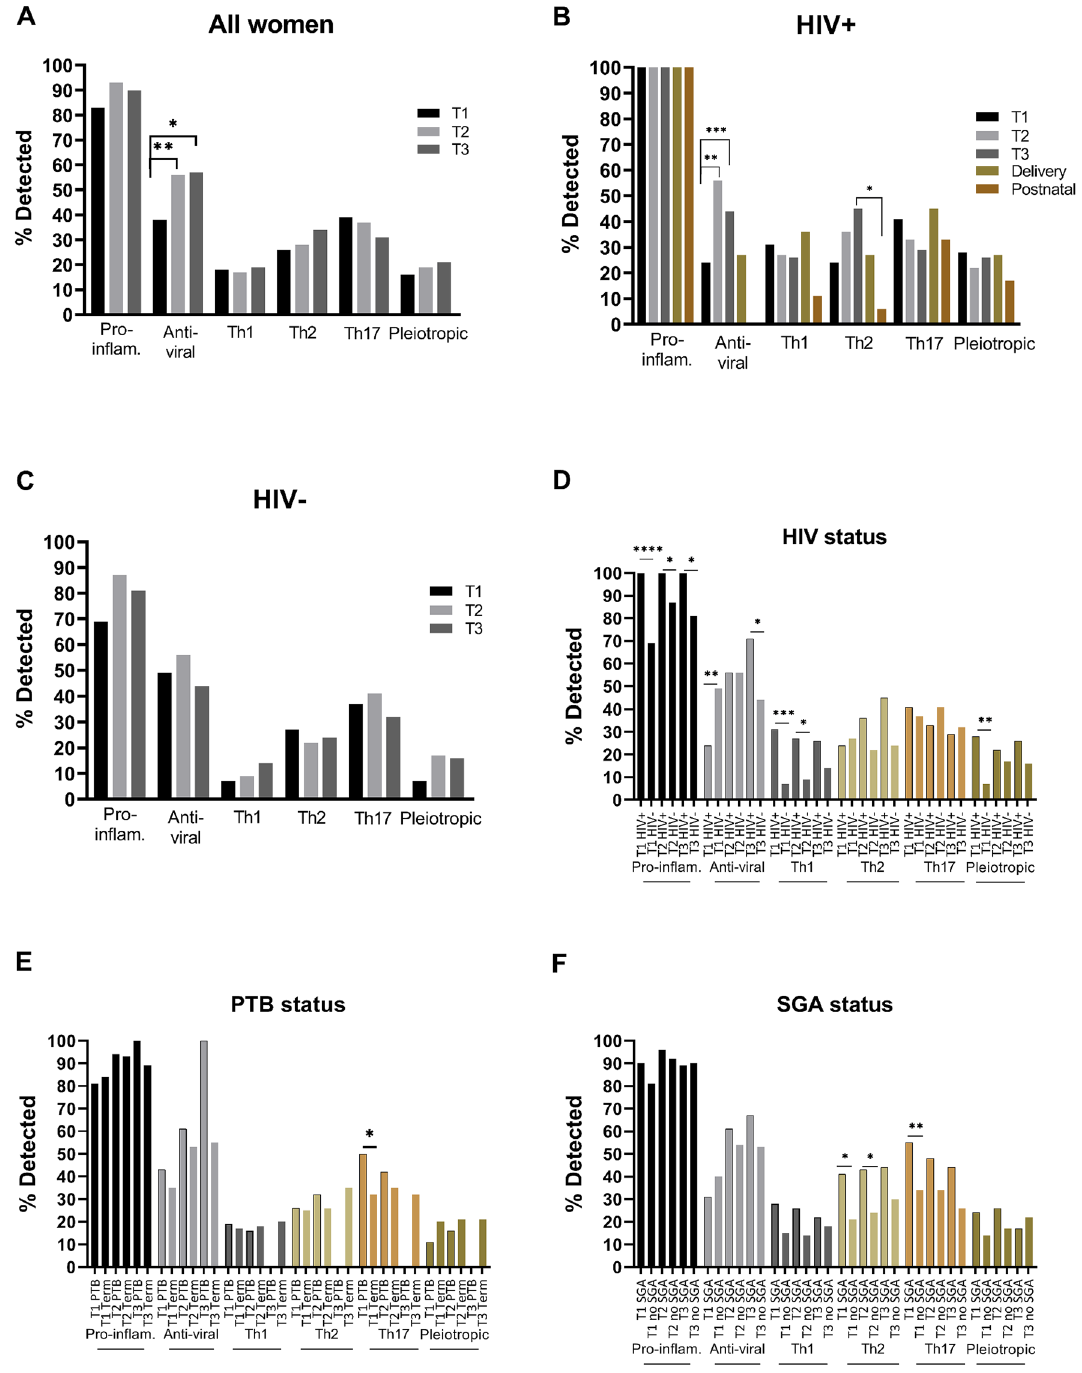
Figure 6. Systemic cytokine subgroups across pregnancy. ( A ) All women, ( B ) women living with HIV (HIV+), ( C ) HIV-negative women (HIV-), ( D ) HIV+ and HIV− women, ( E ) preterm (PTB) and term birth, and ( F ) small-for-gestational-age (SGA) and non-SGA infants. Pro-inflammatory (IL-1β, TNF-α, IP-10, IL-8), anti-viral (IFNα2, IFNβ, IFNλ1, IFNλ2/3), Th1 (IFNγ, IL-2, IL-12p70), Th2 (IL-4, IL-5, IL-13), Th17 (IL-17A, IL-17F, IL-21, IL-22) and pleiotropic (IL-6, IL-9, GM-CSF and IL-10 respectively) cytokines were measured in maternal plasma collected during the first (T1), second (T2) and third (T3) trimester in women living with HIV (HIV+) and HIV-negative (HIV−) women. Data are presented as the percentage of samples in which subgroups of cytokines were detected by multiplex cytokine assay. *P < 0.05, **P < 0.01, ***P < 0.001, ****P <